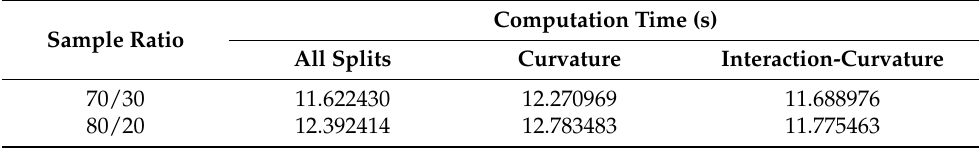
Table 14. Computation time of the decision tree method for different predictor